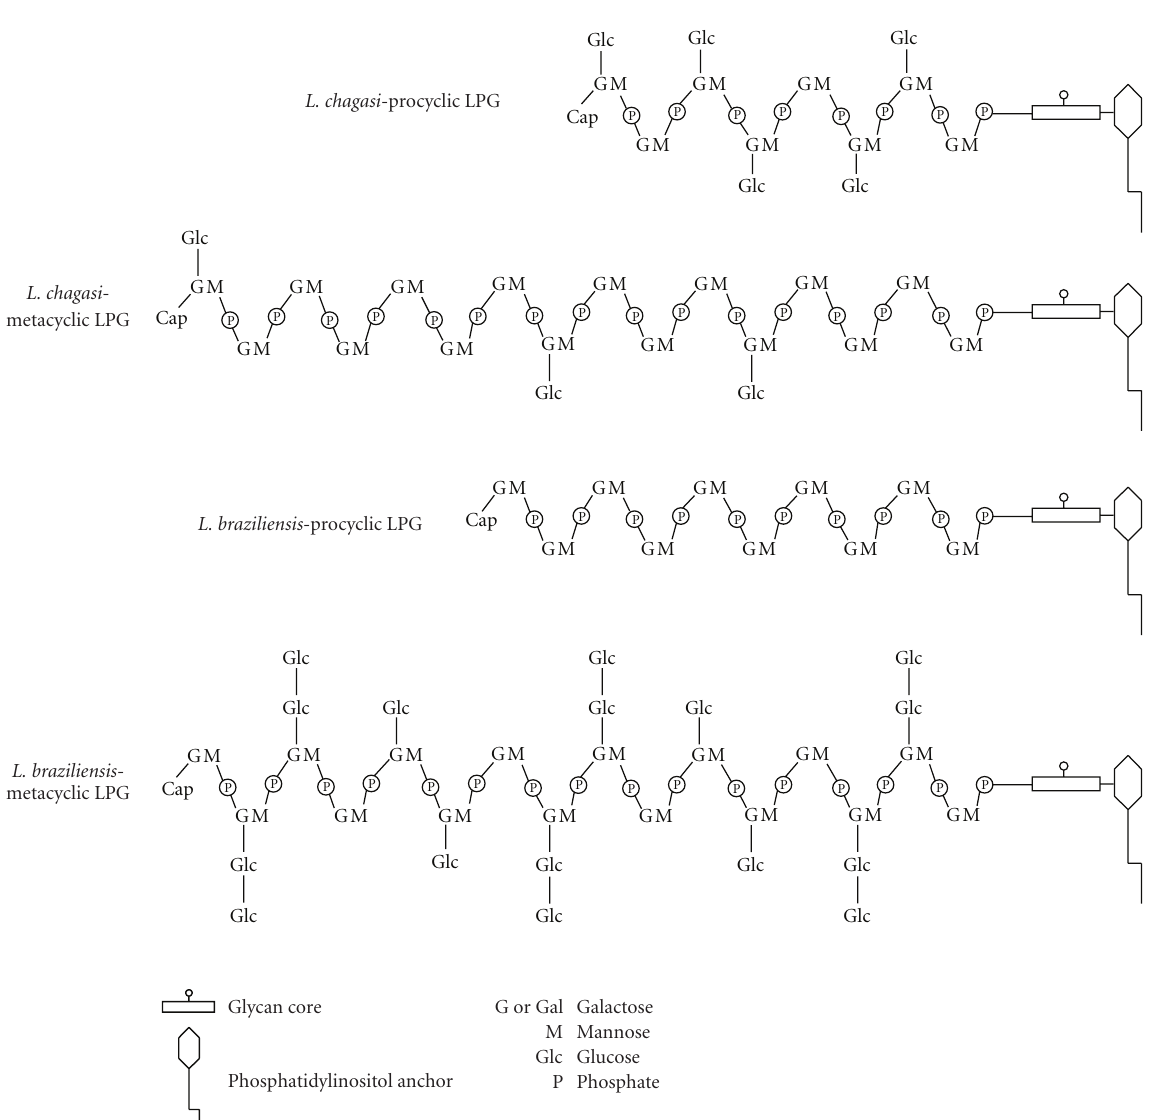
di ff erent vectors [9, 11–17]. All LPGs have a conserved glycan core region of Gal( α 1,6)Gal( α 1,3)Gal f ( β 1,3)[Glc( α 1)- PO 4 ]Man( α 1,3)Man( α 1,4)GlcN( α 1) linked to a 1- O -alkyl- 2- lyso -phosphatidylinositol anchor. LPG intra- and